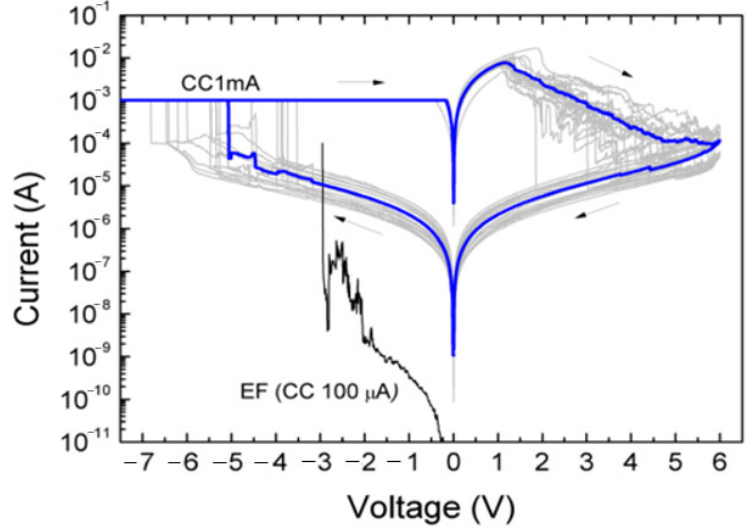
Figure 3. Experimental I–V characteristics of the Au/Zr/ZrO 2 (Y)/TiN/Ti memristive devices. The arrows indicate the direction of the voltage